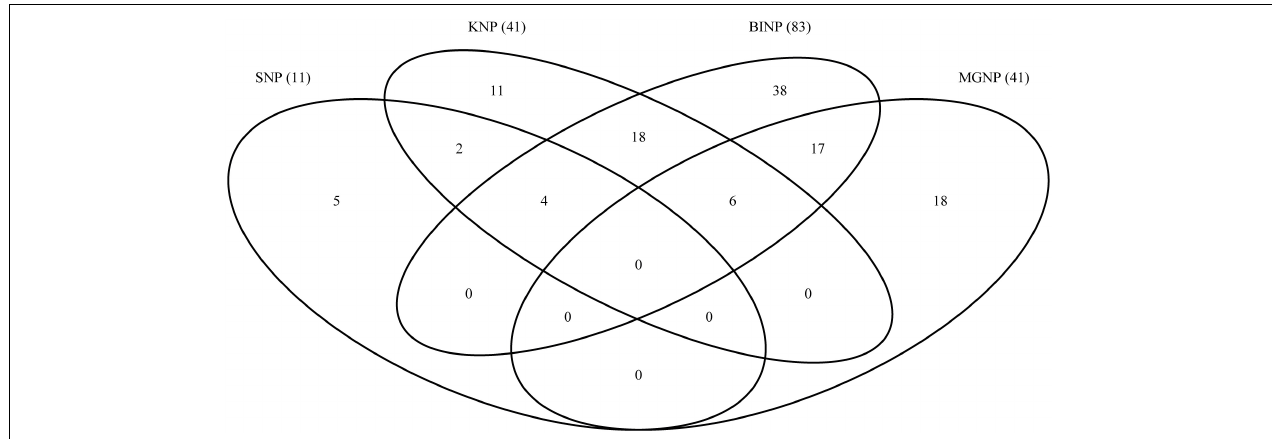
FIGURE 2 | Venn diagram showing numbers of species shared and unique to the four study sites. SNP, Semliki National Park; KNP, Kibale National Park; BINP, Bwindi Impenetrable National Park; MGNP, Mgahinga Gorilla National Park. Numbers in brackets indicate the total species numbers recorded at each site.